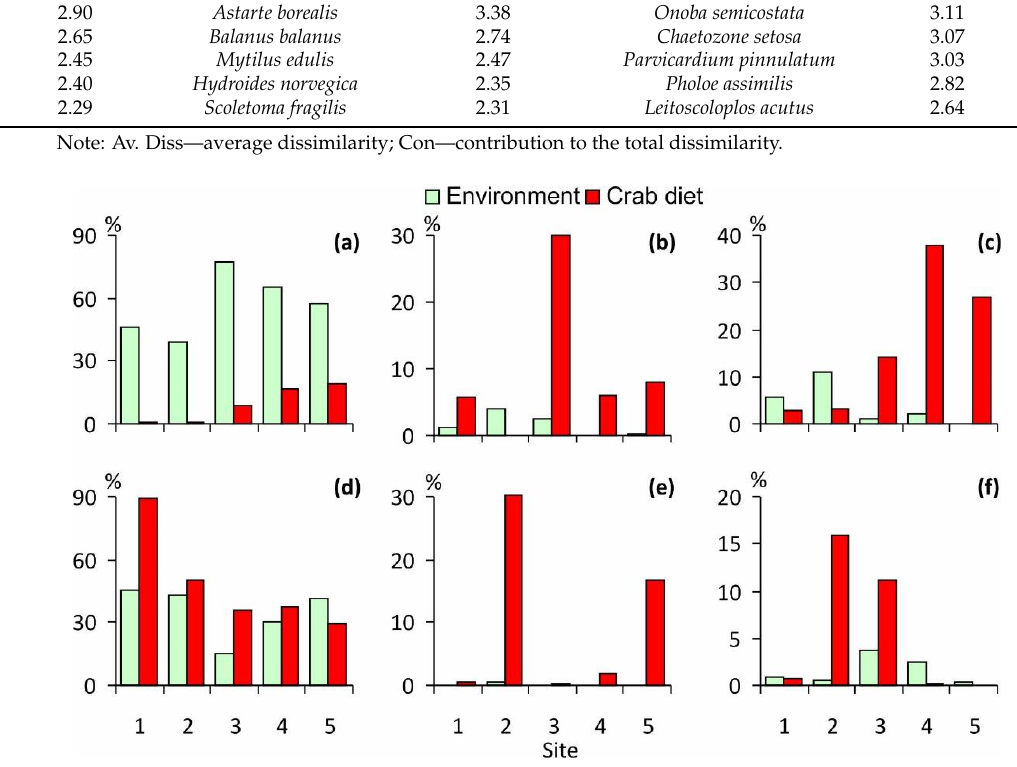
Figure 3. Percent composition by biomass of near-shore invertebrate communities and diet composition of red king crabs in Kola Bay: ( a ) — Polychaeta; ( b ) — Crustacea; ( c ) — Gastropoda; ( d ) — Bivalvia; ( e ) — Echinodermata; ( f ) — others.